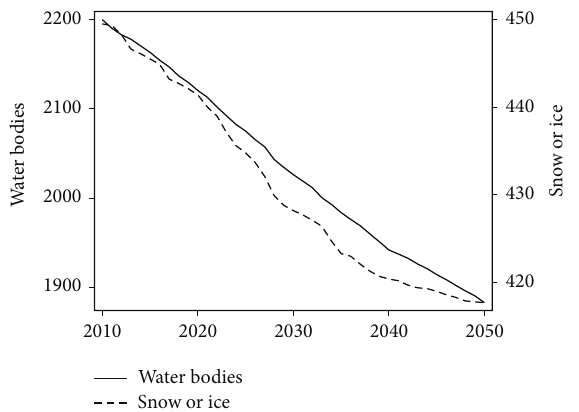
Figure 5: Area changes of water bodies and snow or ice measured by thousand hectares in Qinghai Province, China.